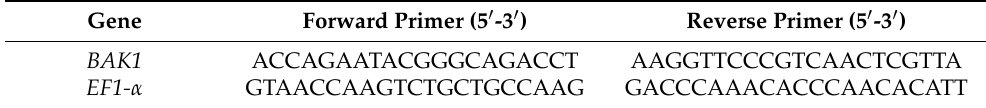
Table 1. BAK1 and EF1- α gene primer sequences for qPCR. Gene